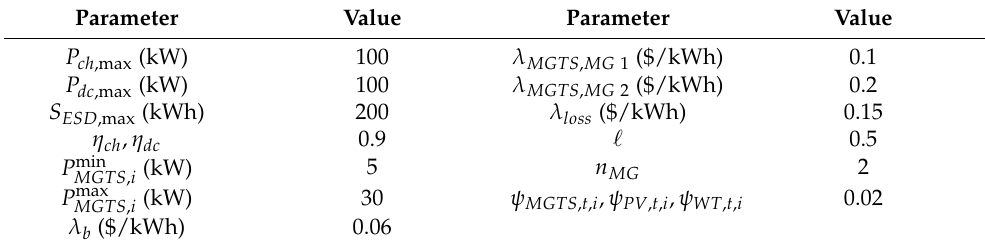
Table 2. A set of parameters to verify the adaptability of AutoML.